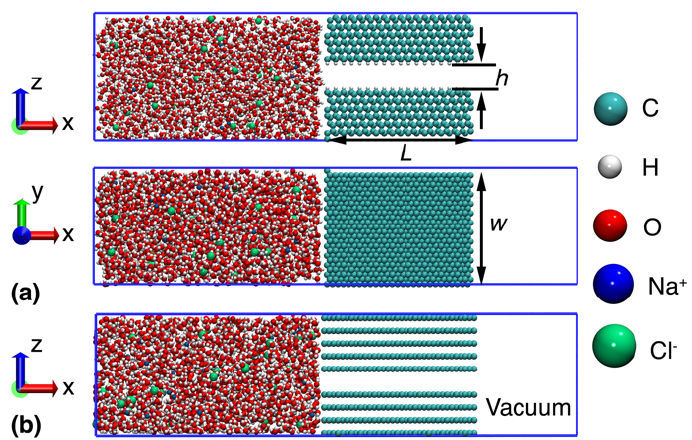
Figure 1. Schematical view of the simulation model. ( a ) Nanochannel constructed from nanometer- thick diamond. L , h and w representing the channel length, height, and width, respectively; and ( b ) Nanochannel constructed from multilayer graphene.